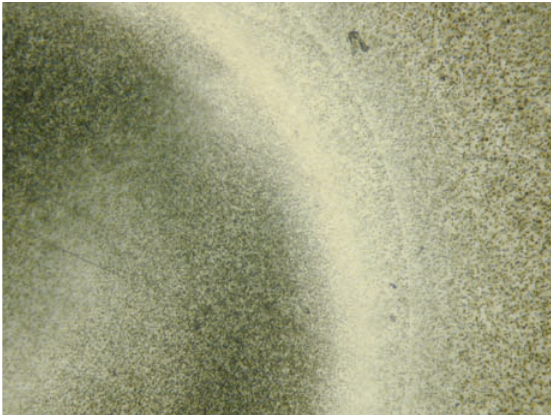
Figure 2. Fluid inclusions in Baltic amber disposed as concentric bands, NII, 20x/0.33